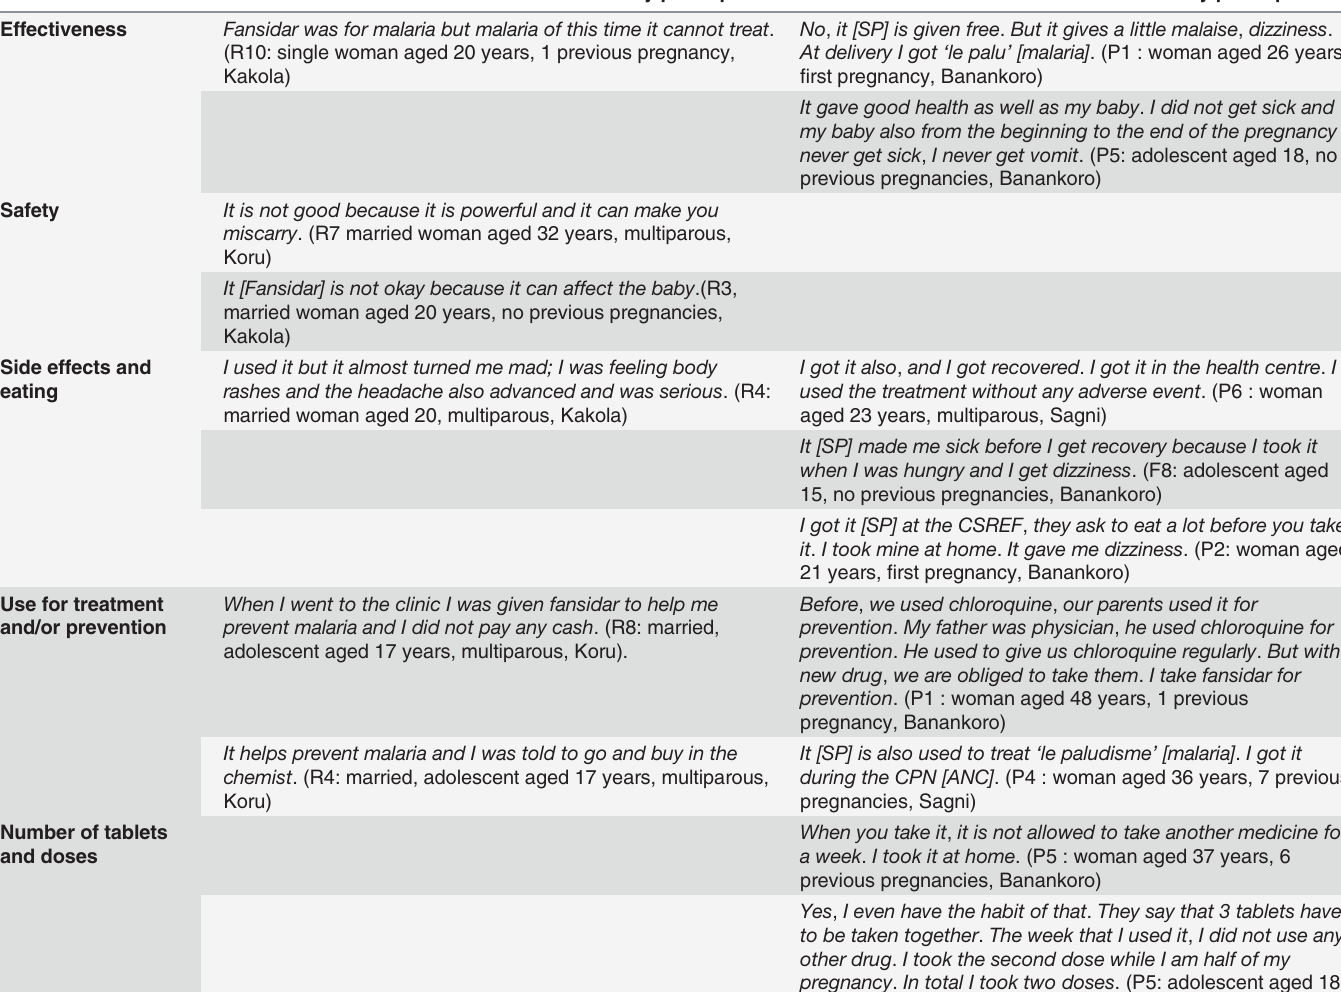
Table 4. Factors affecting pregnant women ’ s practices for the prevention of malaria: IPTp. Themes KENYA: Sub-themes & Quotations from study participants MALI: Sub-themes & Quotations from study participants